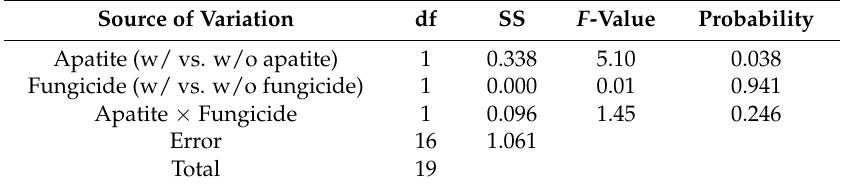
Table 2. F-values and probabilities obtained from a generalized linear model to test the effects of apatite and fungicide on easily extractable glomalin-related soil protein (EE-GRSP) deposition rates.